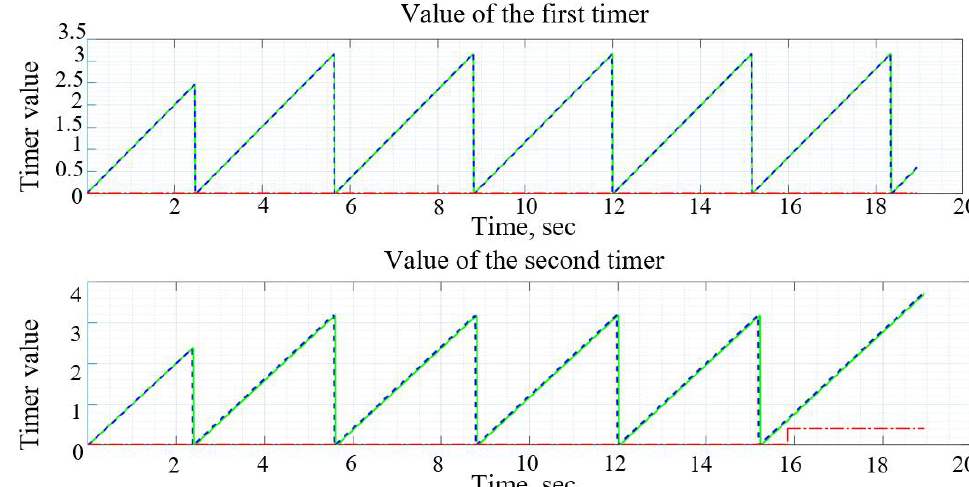
Figure 16. An example of the operation of the algorithm for determining the time skew: blue is the value of the timer that controls the first rail, green is the value of the timer that controls the second rail, and red is the time the failure was introduced into the system.